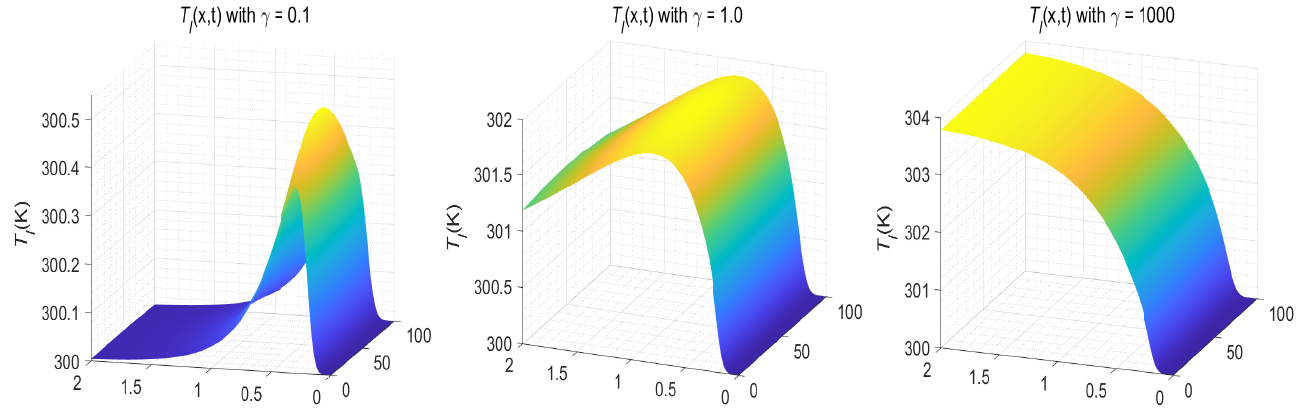
Figure 13. Temperature distributions of T l versus ( x , t ) with various γ when K n = 6.184658, ( α , β ) = ( 0.9,0.9 ) , N = 100, and M = 100 for Example